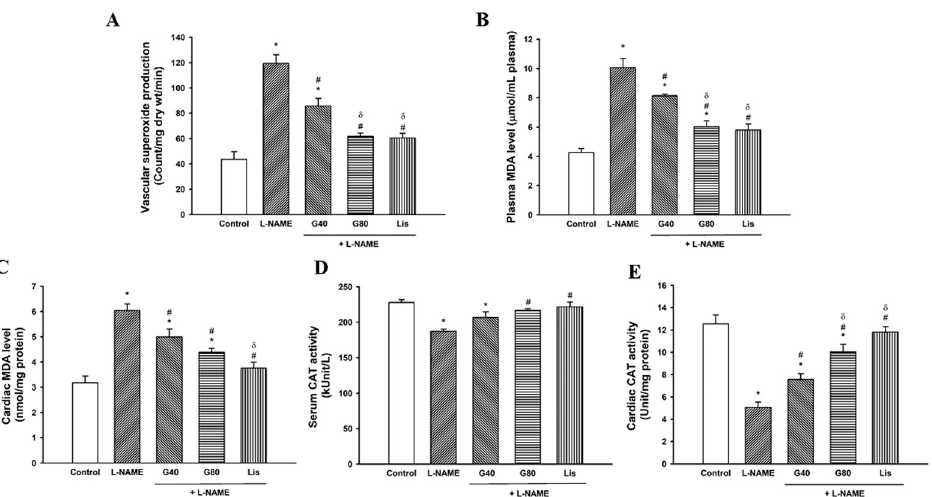
Figure 5. Effect of genistein or lisinopril on vascular O 2 •− production ( A ), plasma MDA level ( B ), cardiac MDA level ( C ), serum CAT ( D ), and cardiac CAT activities ( E ) in rats treated with L-NAME. Data are expressed as mean ± SEM. * p < 0.05 vs. control, # p < 0.05 vs. L-NAME, and δ p < 0.05 vs. G40 ( n = 8/group). O 2 •− , superoxide anion; MDA, malondialdehyde; CAT, catalase; control, normotensive rats; L-NAME, N ω -nitro-L-arginine methyl ester hydrochloride; L-NAME + G40, L-NAME hypertensive rats treated with genistein 40 mg/kg; L-NAME + G80, L-NAME hypertensive rats treated with genistein 80 mg/kg; and L-NAME + Lis, L-NAME hypertensive rats treated with lisinopril 5